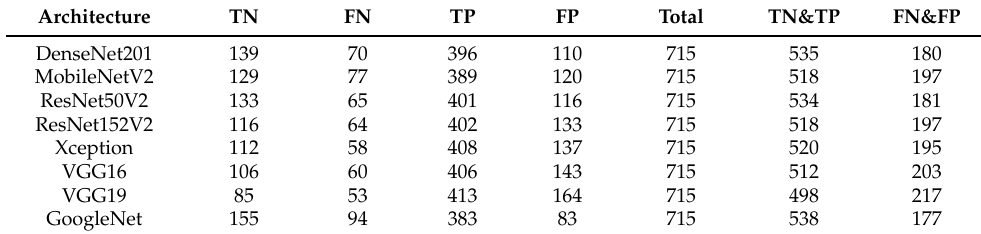
Table 3. Confusion matrix data for all architectures used in the experiment. TP, true positive. FN, false negative. TN, true negative. FP, false positive.